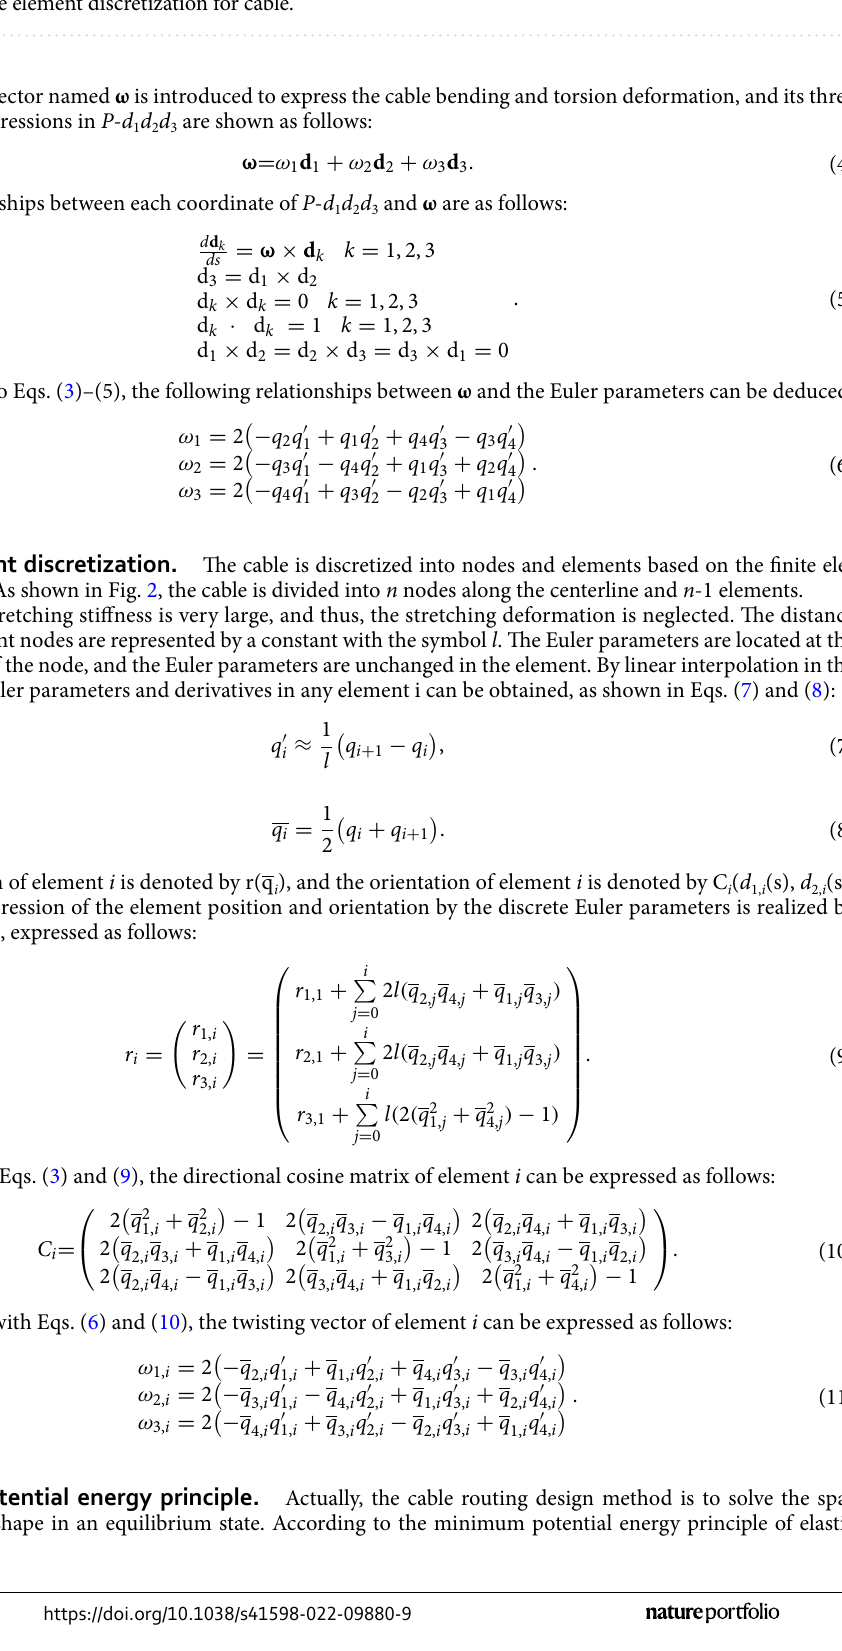
Figure 2. Finite element discretization for